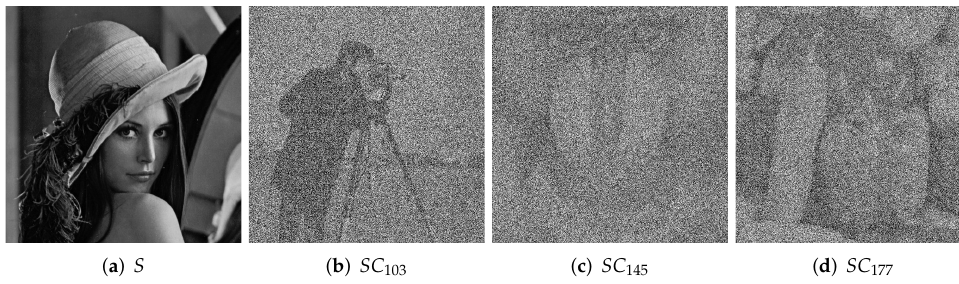
Figure 8. Experiment 1 of thumbnail secret sharing.